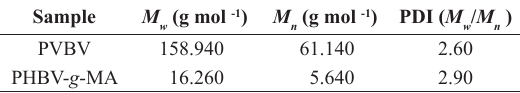
Table 3 – Weight-average molecular weights ( Mw ), number- average molecular weights ( Mn ) and polydispersity index (PDI) of PHBV and PHBV- g -MA